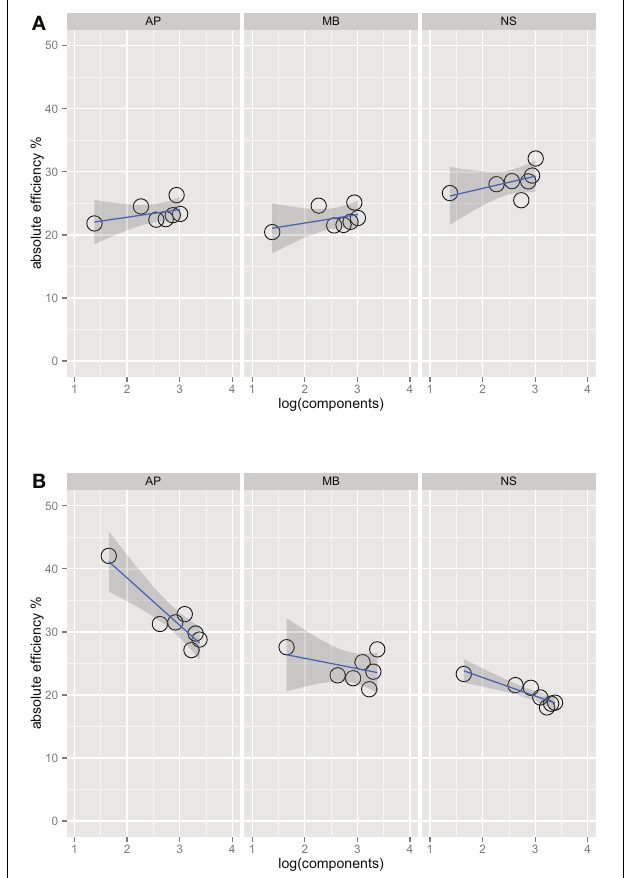
FIGURE 2 | Absolute efficiency for three observers in the one octave (A) and two octave (B) spatial frequency bandwidth conditions. Unlike Figure 1 , the fits in this plot do include the narrowest bandwidth condition. Including this point has a large effect on the efficiency versus bandwidth function for the two-octave spatial frequency condition. Observers are the most efficient at the detecting this stimulus, perhaps because it is a good match to a single component channel (Wilson et al., 1983).